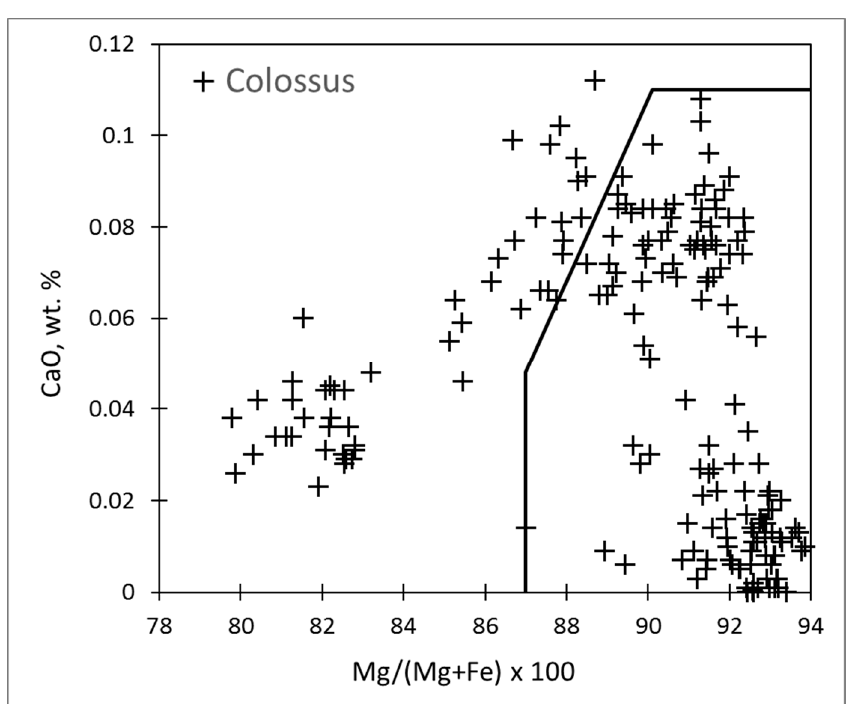
Figure 2. Olivine xenocrysts from Colossus kimberlites, Zimbabwe. Data from work in [29]. Solid line is the boundary between low-Cr megacryst and peridotitic olivines.